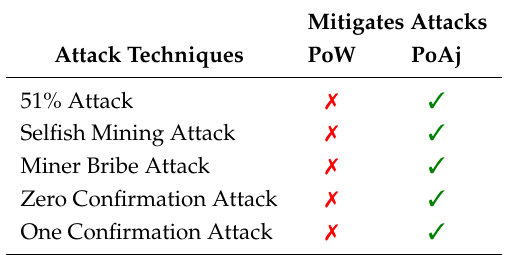
Table 1. The effectiveness of PoAj compared to current approach. Mitigates Attacks Attack